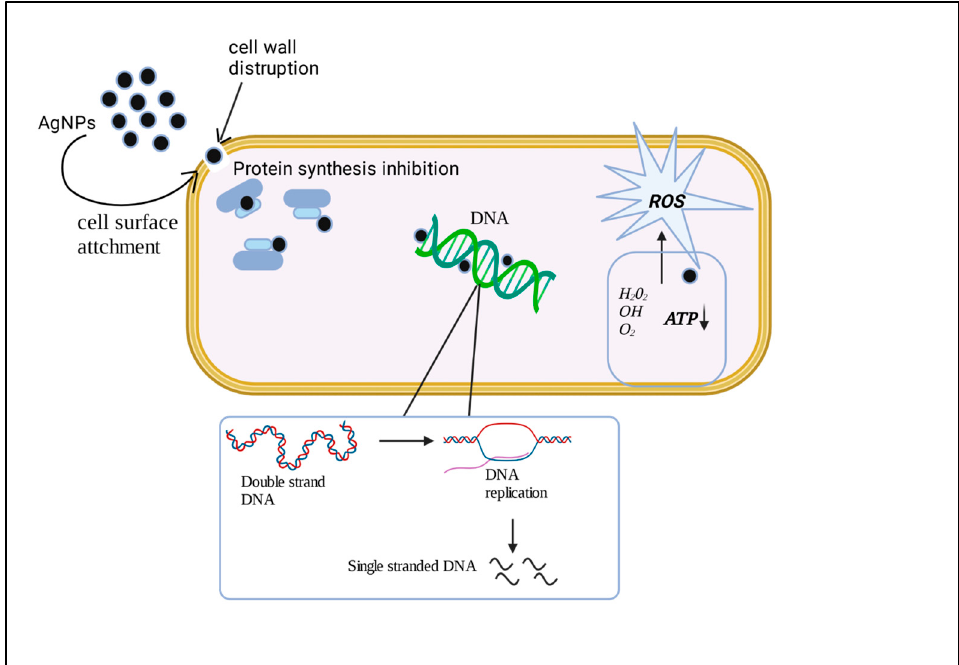
Figure 2 . The figure explains the mechanical approach to NPs against the bacteria and the biofilm. The nanoparticles attach to the bacterial cell wall, penetrate the bacterial cell, and alter the different metabolic pathways. It affects DNA replication and protein synthesis; due to oxidative stress, ROS generation takes place. Furthermore, ultimately, it leads to cell death.